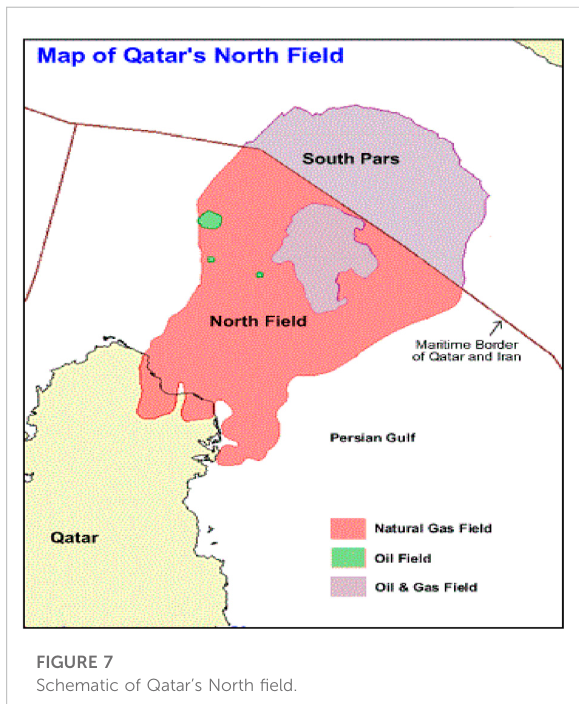
FIGURE 7 Schematic of Qatar ’ s North fi